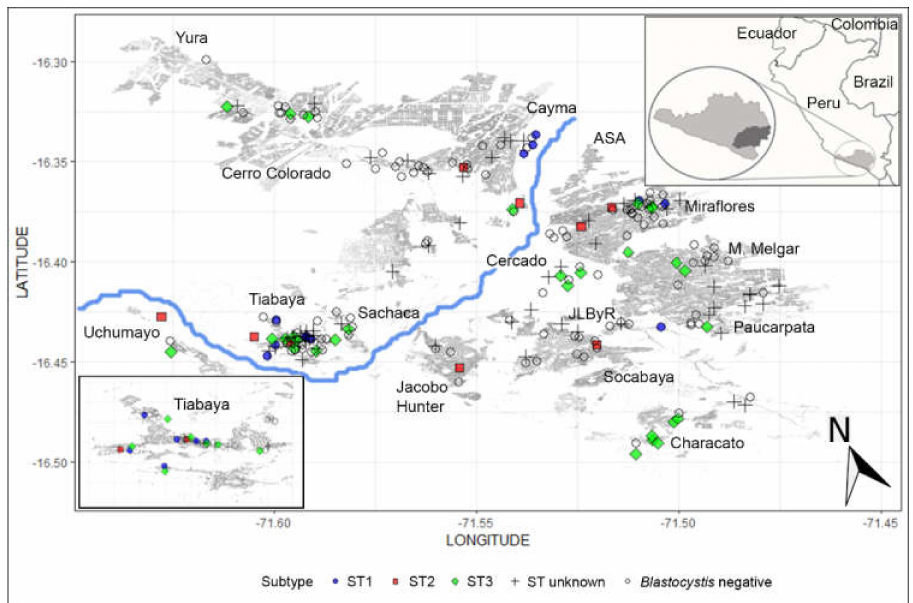
Figure 1. Spatial distribution of the Blastocystis subtypes. All urban, periurban, and rural districts in Arequipa city are shown.